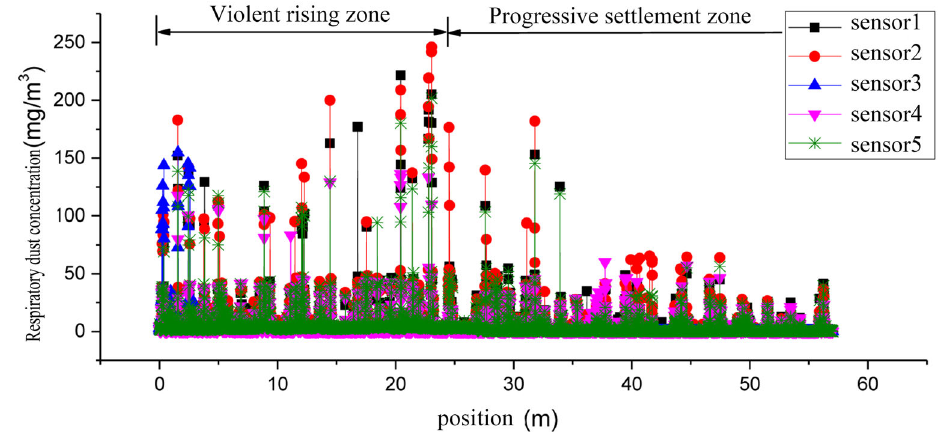
Fig. 5 Division of area where respirable dust was